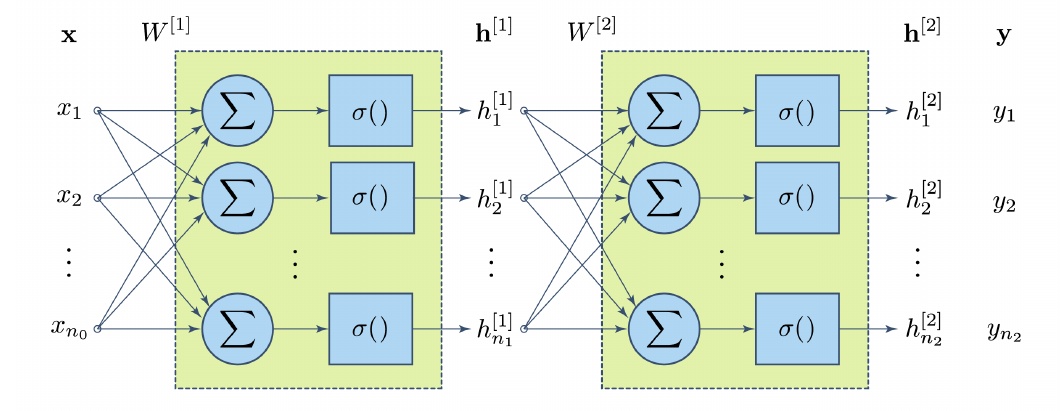
Figure 6. Two-layer neural network architecture. For the sake of simplicity and clarity, individual weights are not